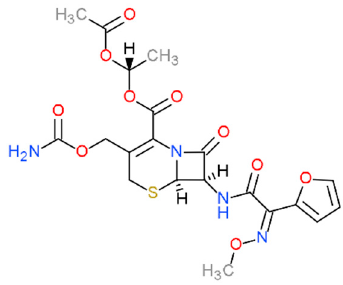
Figure 1. Chemical structure of cefuroxime axetil